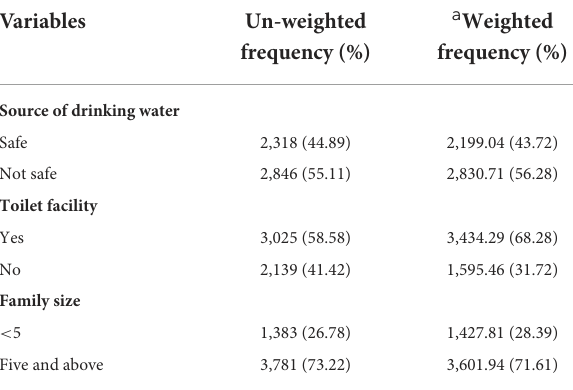
TABLE 3 Household and maternal characteristics of under-five children mini EDHS